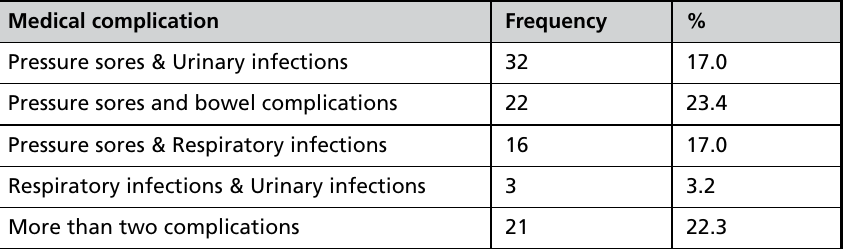
Table 3: Percentage distribution of participants with more than one medical